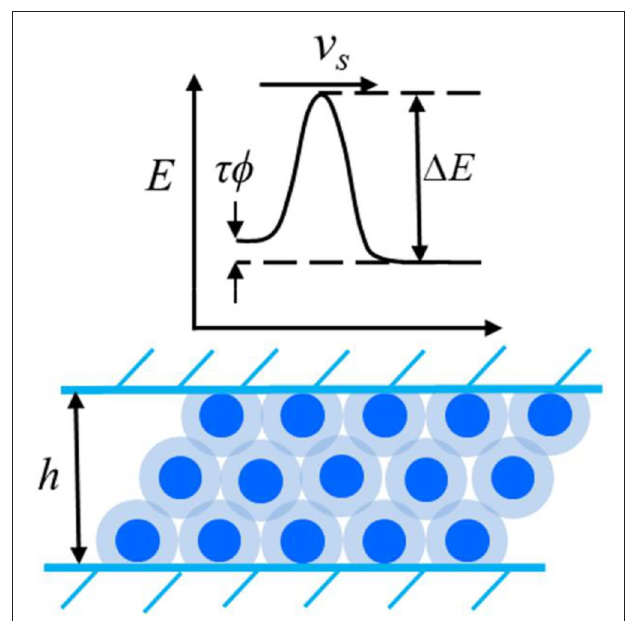
FIGURE 2 | Schematics of the shear stress modify the energy barrier in the hydration confined